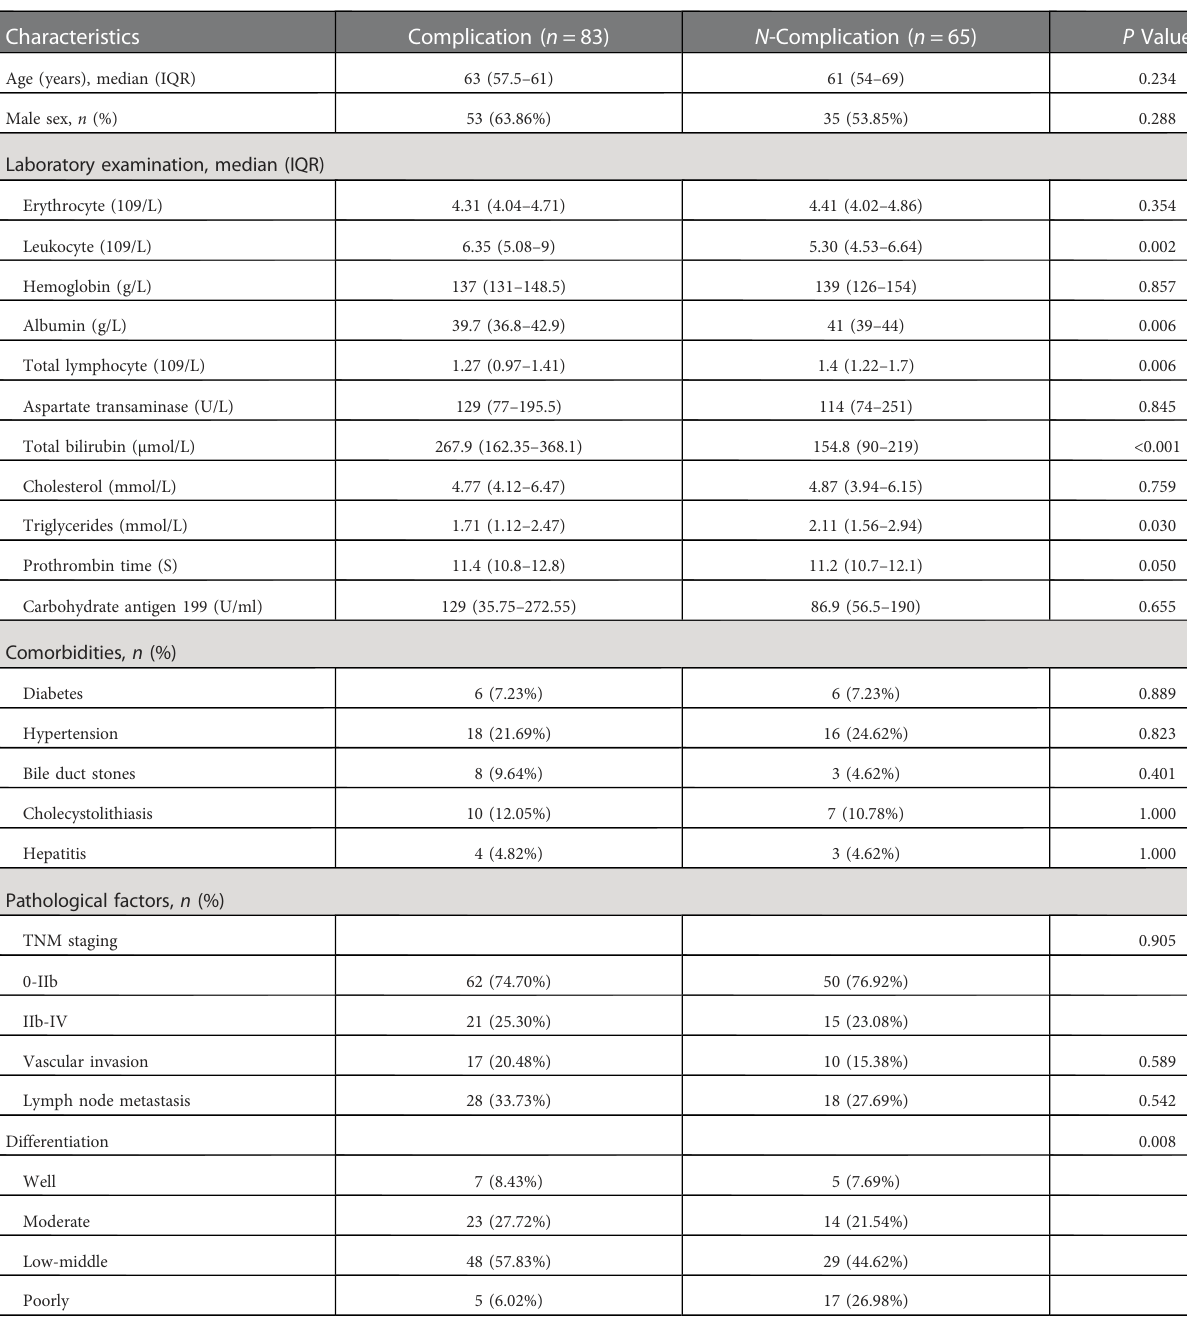
TABLE 1 Clinical characteristics of the patients at